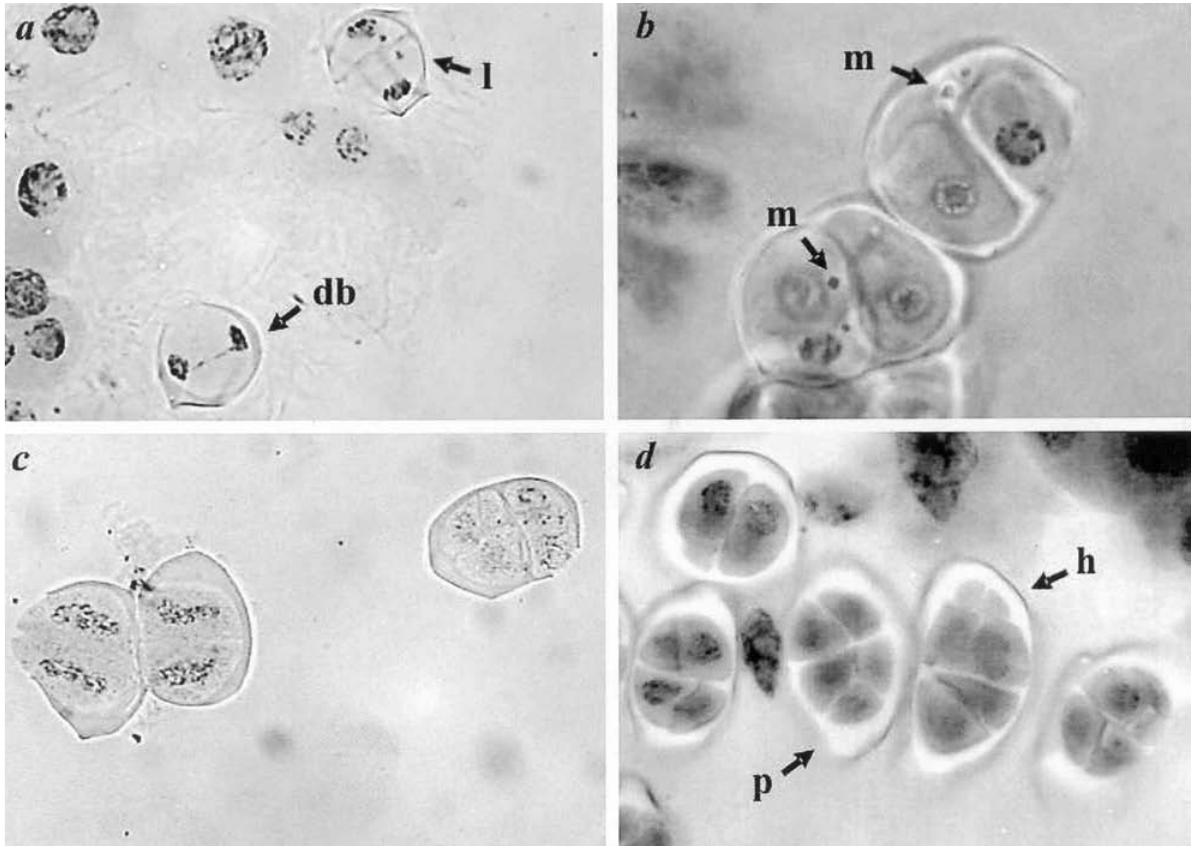
Figure 1 - Meiotic abnormalities of regenerants derived from calluses of clones 265 and 357. ( a ) Regenerant 5-I derived from callus 46 of clone 265, lag- gard (l) in cytokinesis I and dicentric bridge (db) in telophase I. ( b ) Regenerant 3-C derived from callus 11 of clone 357, sporads with micronuclei (m). ( c ) Regenerant2-Iderivedfromcallus46ofclone265,twosporadswithchromatidsegregationinprophaseIIandprematureendofmeiosis(left)andnormal tetrad (right). ( d ) Regenerant 8-I derived from callus 66 of clone 265, pentad (p) and hexad (h). Table 3 - Fruit, seed set and percentage seed germination for clones 265 and 357 and their derived regenerants classified according to ploidy and meiotic behavior.